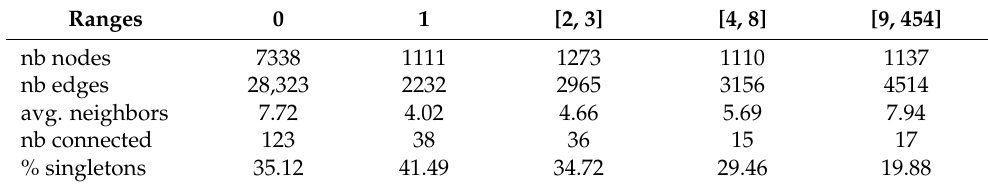
Table 3. Interaction data for D. melanogaster proteins depending on their rate of phosphorylation. Ranges 0 1 [2, 3] [4, 8] [9, 454] nb nodes 7338 1111 1273 1110 1137 nb edges 28,323 2232 2965 3156 4514 avg. neighbors 7.72